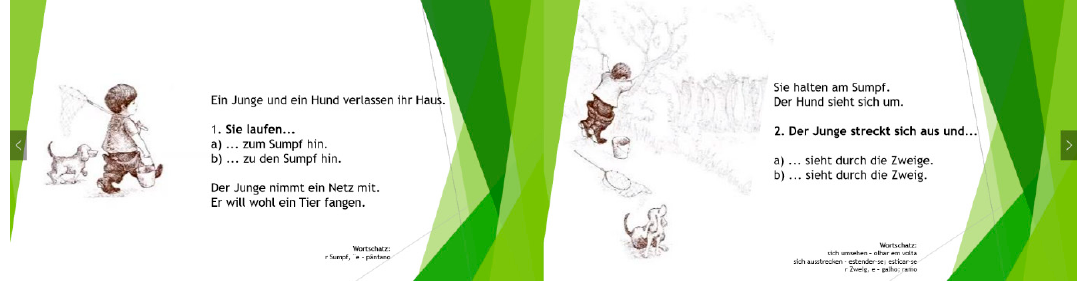
Figure A14. Pretest: Binary-choice recognition task.